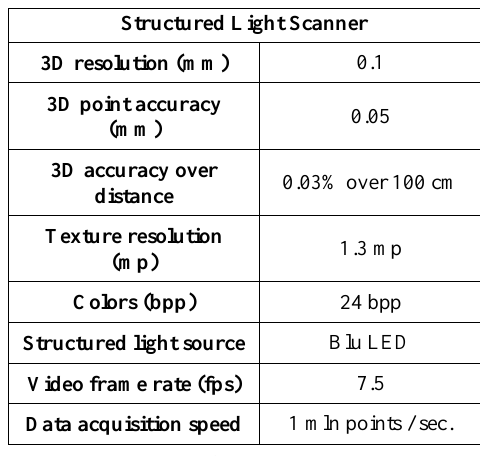
Table 2: Artec's Spider instrument general specs.